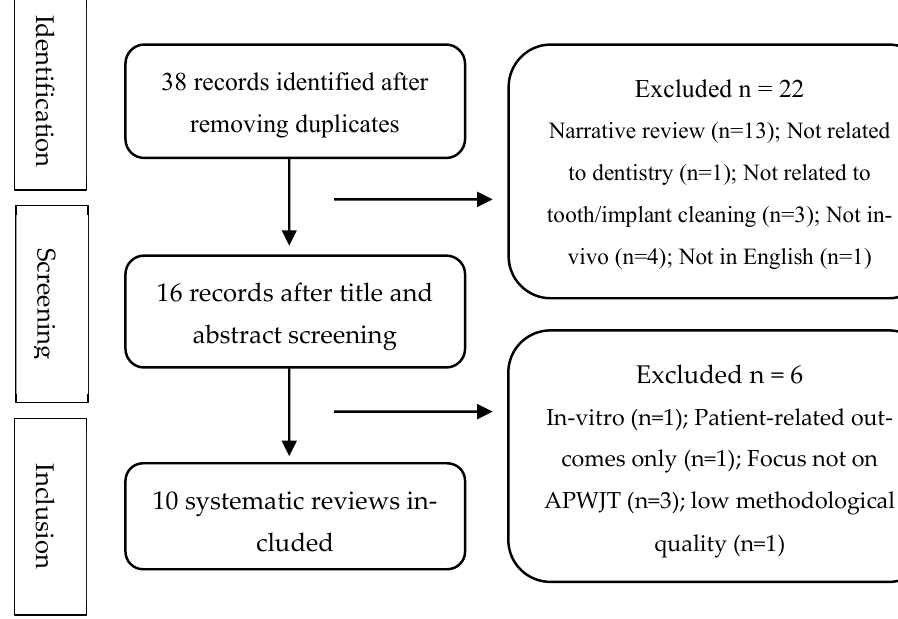
Figure 1. Modified PRISMA 2020 flow diagram of study selection [29].